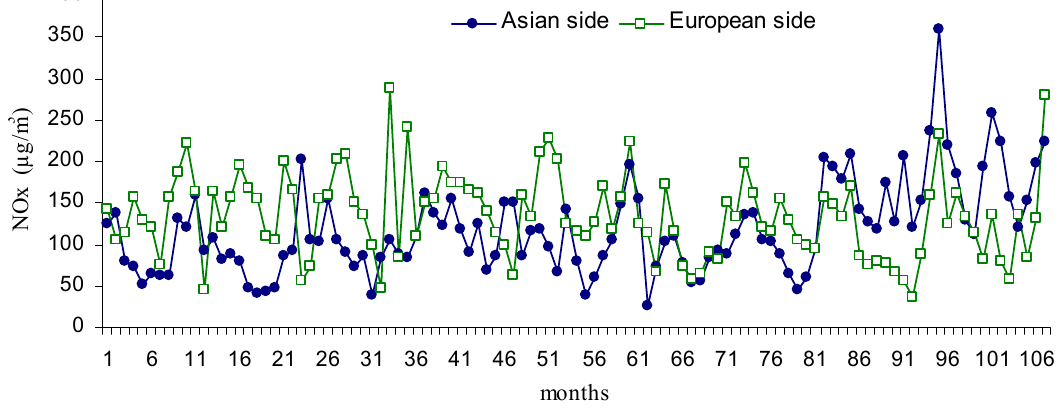
Figure 6. Monthly changes of NO